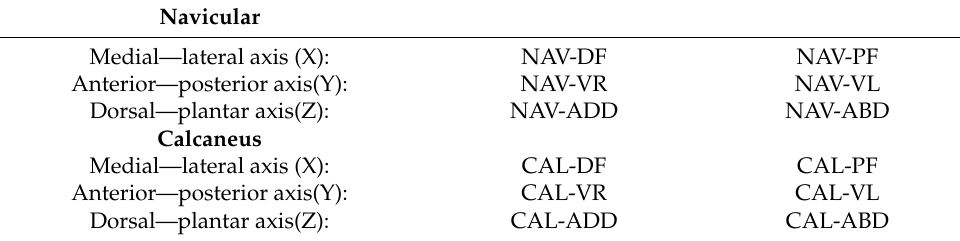
Table 1. The table represents the Cartesian coordinate axes (X), (Y), and (Z), for the medial-lateral axis the dorsal flexion is a positive value (X+) and the plantar flexion is a negative value (X-), for the anterior-posterior axis the varus is a positive value (Y+) and the valgus is a negative value (Y-) and for the dorsal-plantar axis the adduction is a positive value (Z+) and the abduction is a negative value